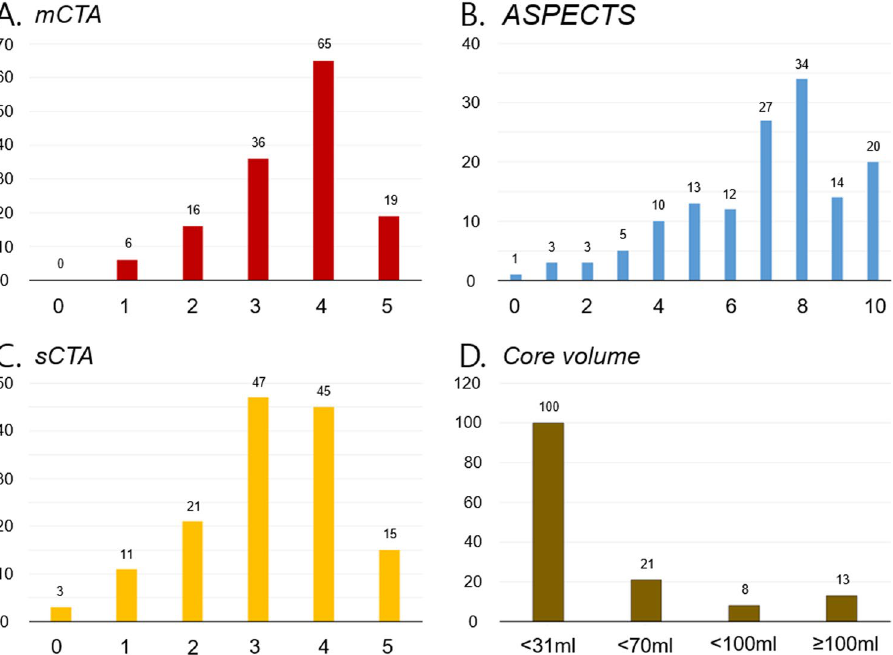
Figure 1. Distribution of mCTA collateral scores, ASPECTS scores, and MR ADC volume. mCTA, multiphase computed tomographic angiography collateral score; ASPECTS, Alberta stroke program early CT score; sCTA, single-phase CT angiography collateral score.